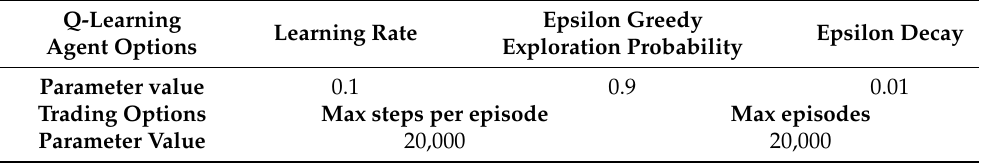
Table 7. Setting parameters for the Q-learning agent and training options.